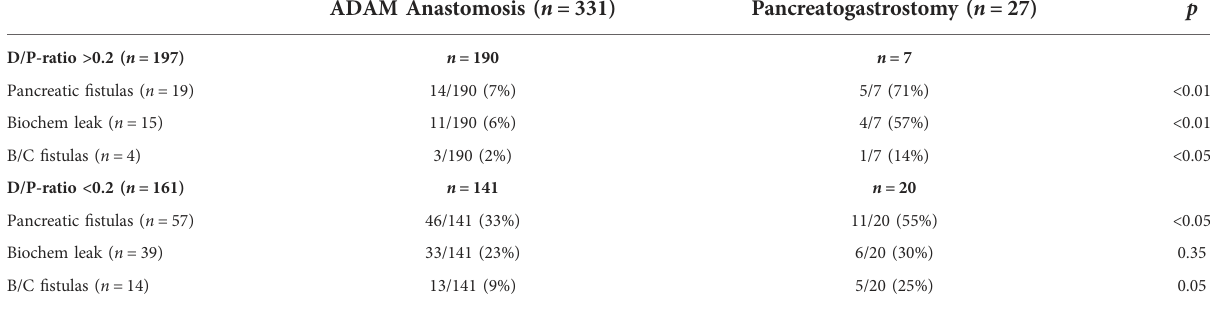
TABLE 3 Comparison of ADAM anastomosis vs. pancreatogastrostomy in relation to D/P ratio. ADAM Anastomosis ( n =